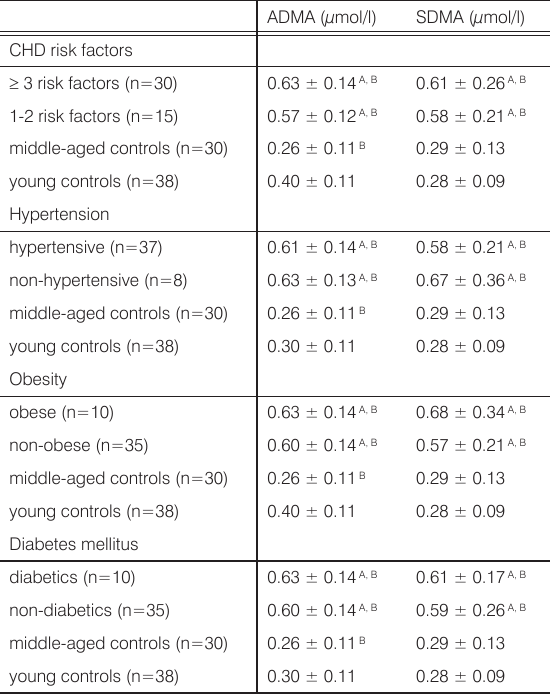
Table 2. ADMA and SDMA according to the number of cardio- vascular risk factors, and to the presence or absence of hypertension, obesity and diabetes